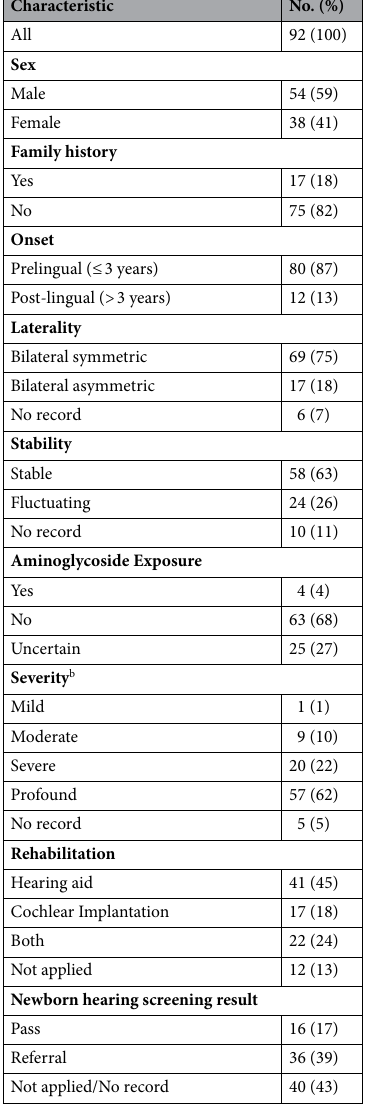
Table 1. Characteristics of the study cohort a . a All members in this cohort have bilateral hearing loss; the precise type of hearing loss are not always recorded, most recorded cases are sensorineural; b Severity is determined by the hearing level of the better ear; WHO grading rule is adopted (Mild: 26–40 dB; Moderate: 41–60 dB; Severe: 61–80 dB; Profound: > 80